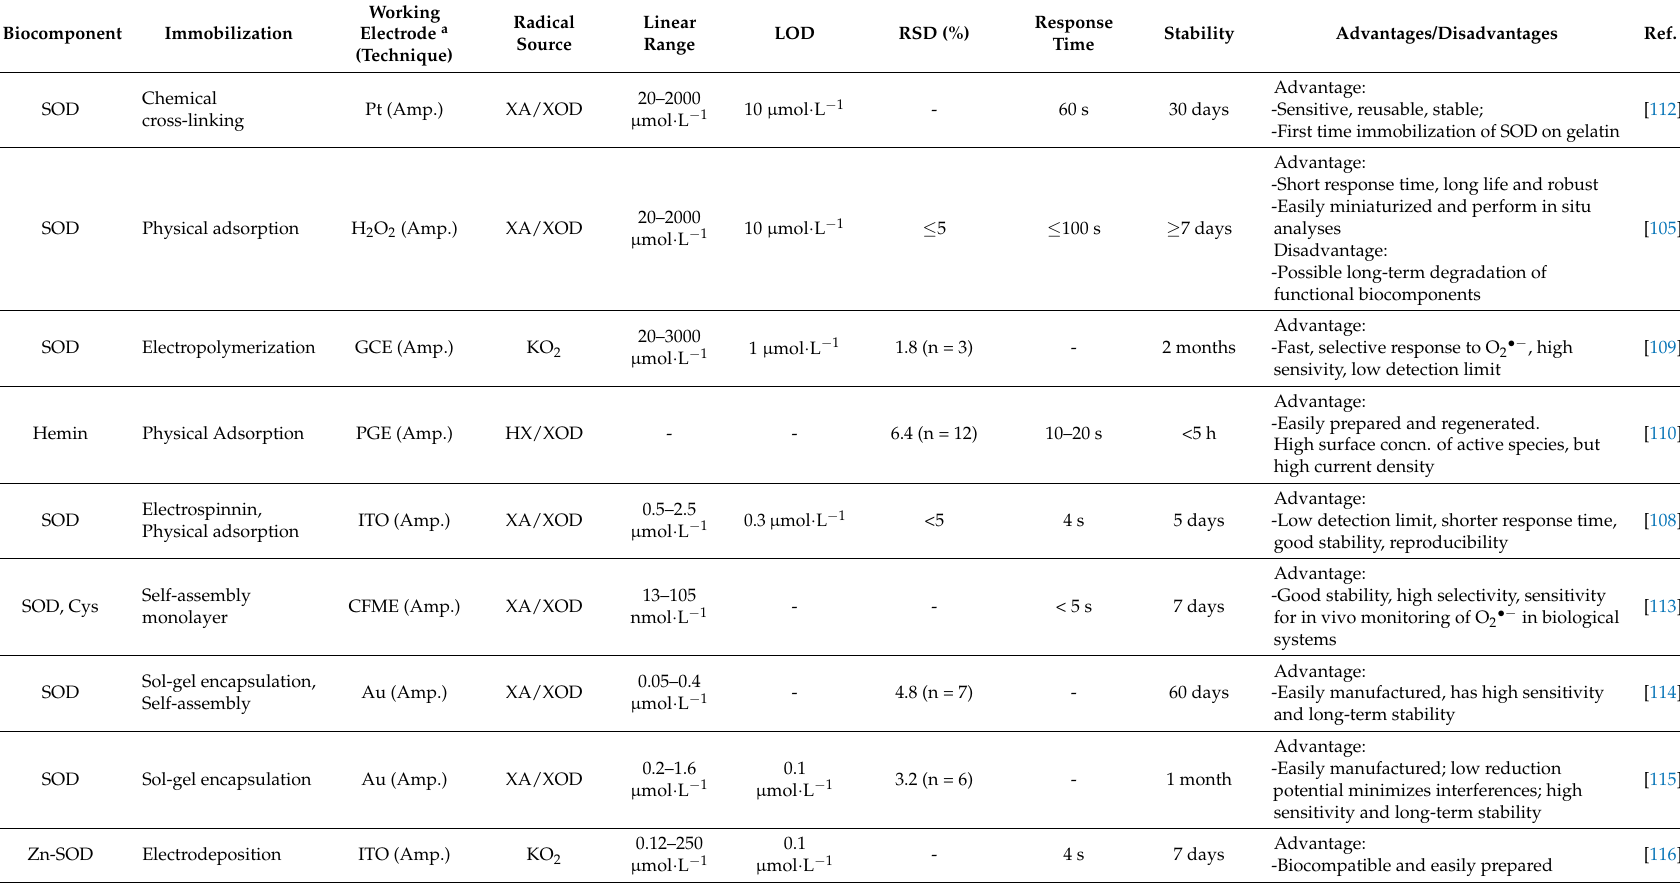
Table 5. Biosensors for electrochemical detection of superoxide anion